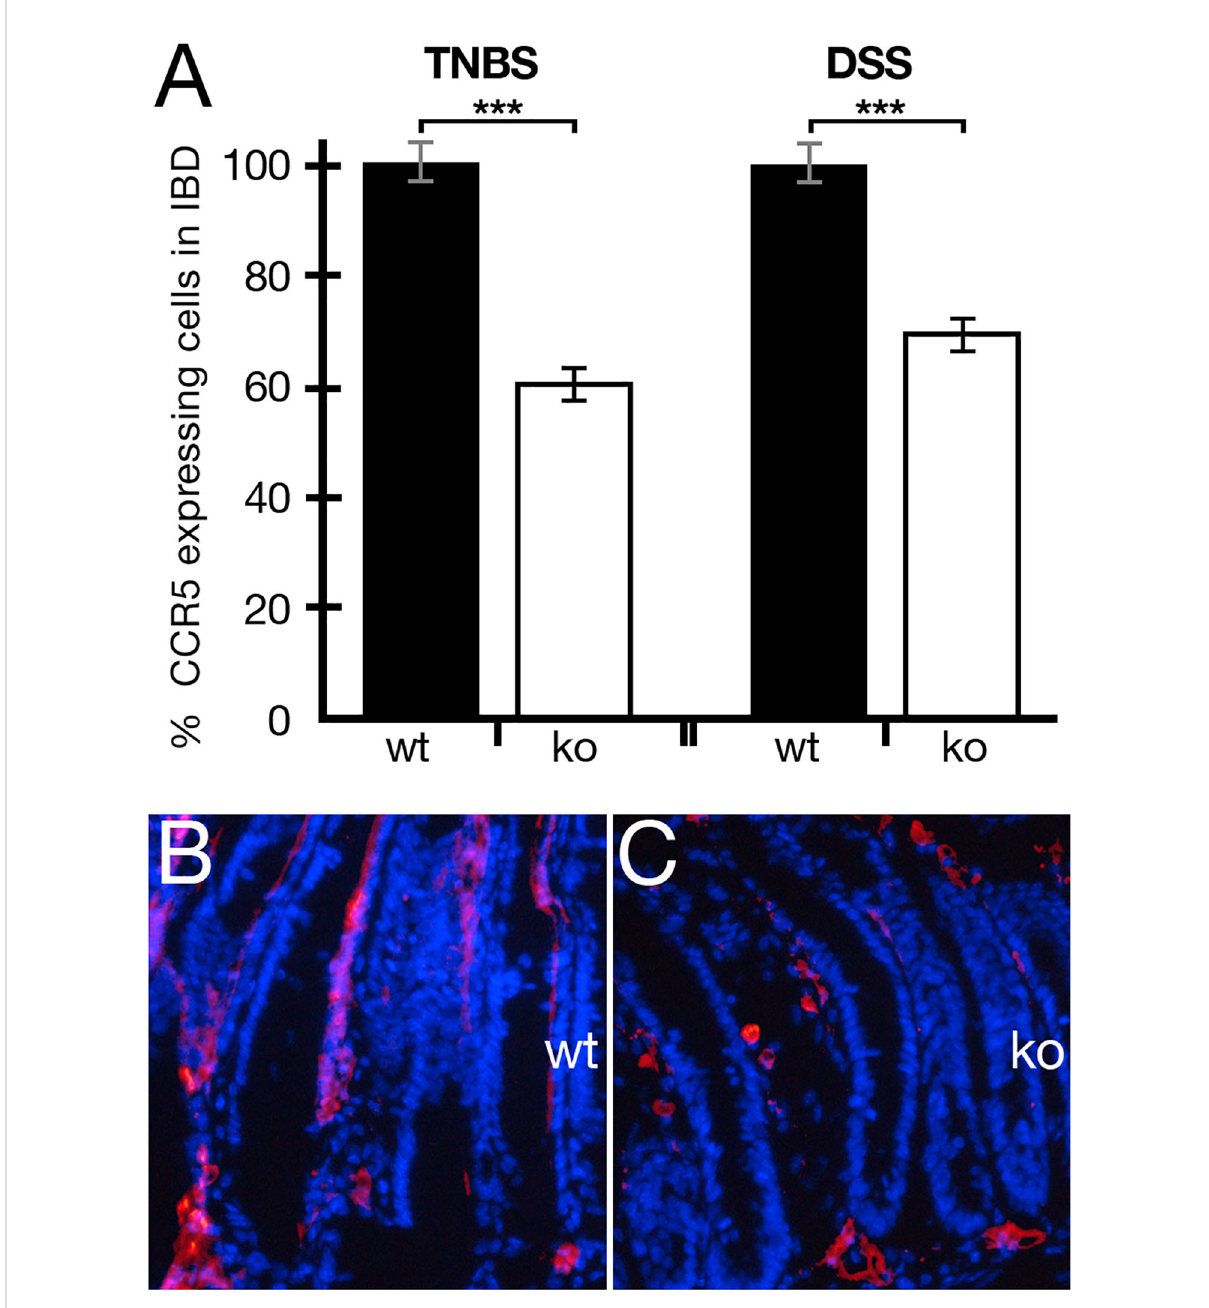
FIGURE 1 The absence of periostin reduces the number of CCR5-expressing cells in the colon/intestine of 2,4,6-trinitrobenzene sulfonic acid (TNBS)/ dextran sodium sulfate (DSS)-induced colitis in mice. (A) The percentage of CCR5-expressing cells was normalized to wild-type mice (black histogram) and compared to periostin-de fi cient mice (white histogram). (B, C) Representative colon sections of the wild-type (B) and periostin- de fi cient (C) TNBS models. Immuno fl uorescence staining using the CDKR-5 antibody (red) and DAPI (blue). Please note the more regular appearance of villi in (C) supporting the clinical in fl ammatory bowel disease (IBD) scoring fi nding that periostin-de fi cient animals are more protected from chemically induced IBD. Please also note that CCR5-speci fi c immuno fl uorescence captures of the small intestine in the DSS model are presented in Figures 3C (wt) and (D) (ko). At least three animals and between fi ve and seven areas in at least three sections were used for determining the numbers for the graph in (A) . *** P <